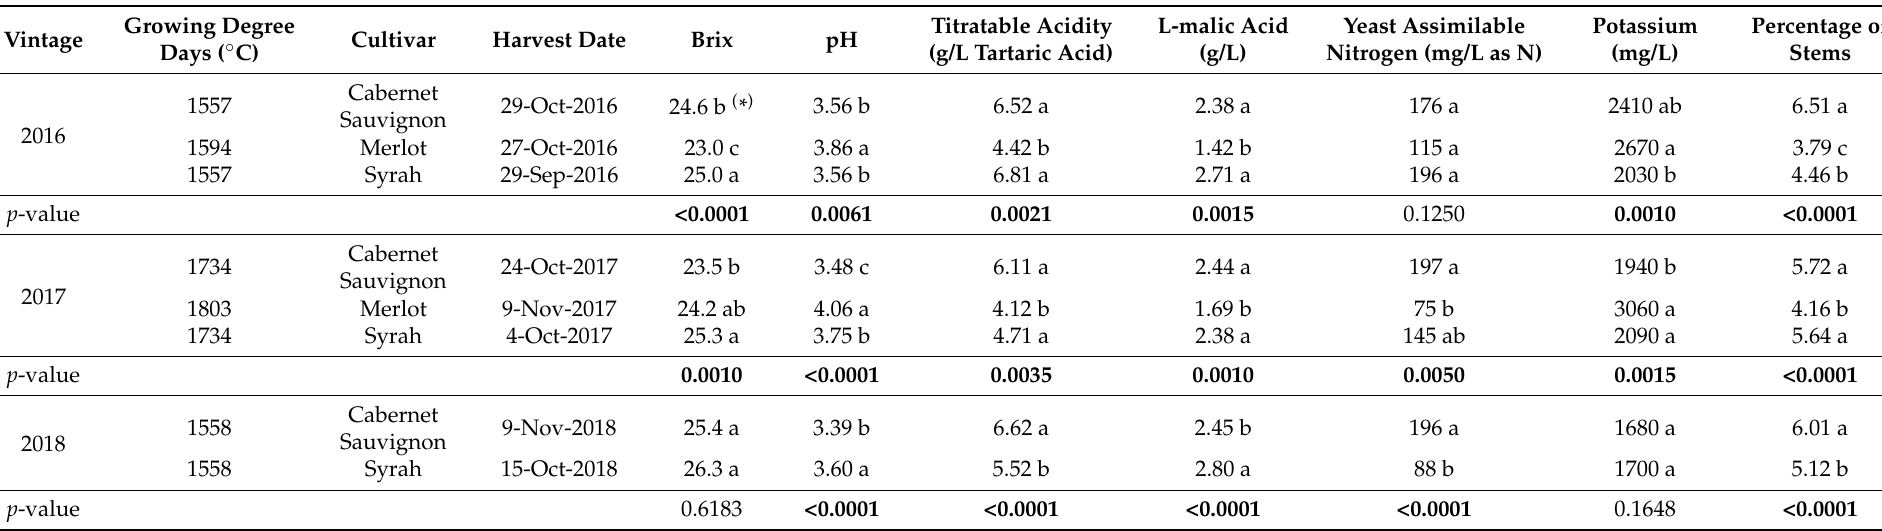
Table 1. Initial grape chemistry, harvest dates, growing degree days, and percentage of stems in Cabernet Sauvignon, Merlot and Syrah grapes at the time of harvest. Values represent the average of 3 ( n = 3) field